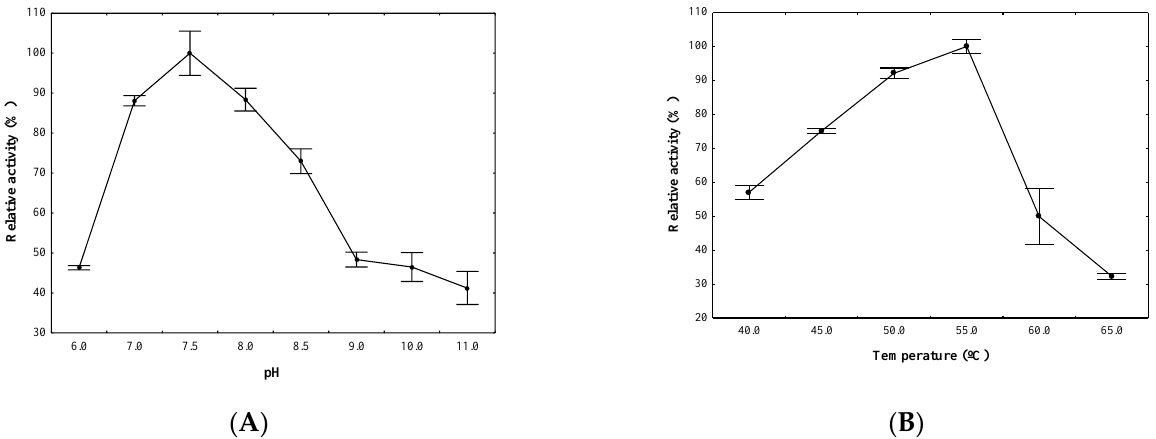
Figure 2. Optimum pH ( A ) and temperature ( B ) for the activity of purified protease from Bacillus sp. P45. Enzymatic activity was determined with the use of azocasein as substrate by incubation for 30 min at different pH and temperature values.